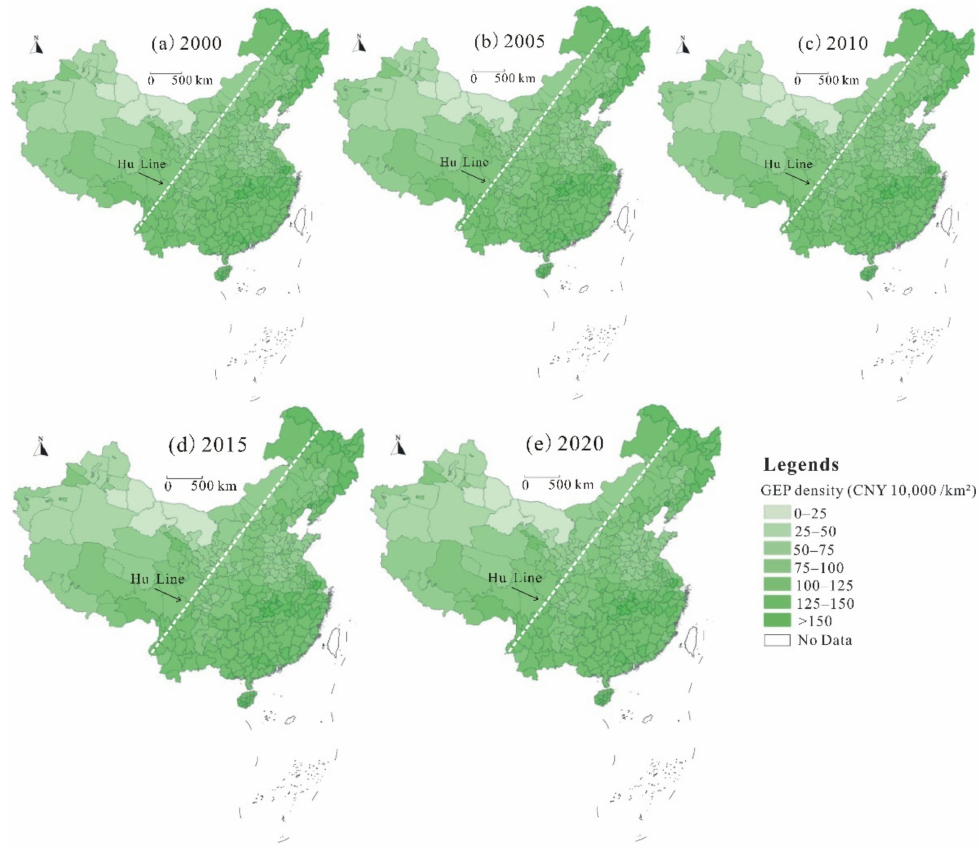
Figure 3. Spatial distribution characteristics of gross ecosystem production density (ED) in Chinese Mainland during the investigation